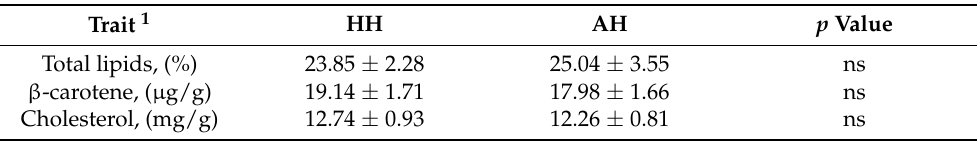
Table 3. Total lipids, β -carotene, and cholesterol content in egg yolks obtained from commercial hybrid hen (HH) and Nera Atriana laying hen (AH).